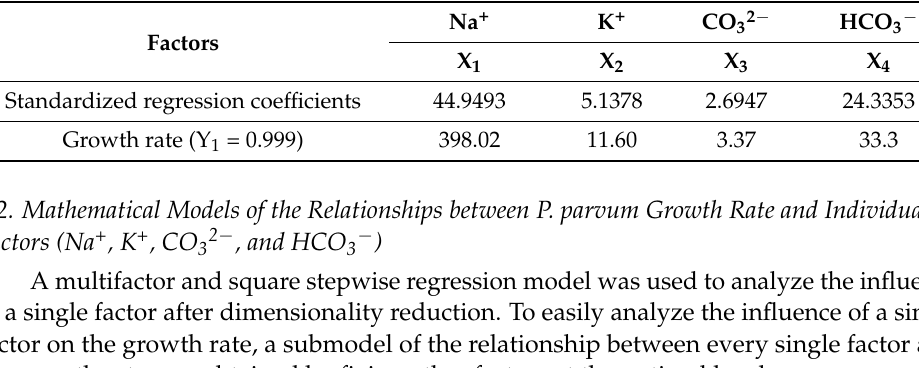
Table 5. The standardized regression coefficients of the model and optimal combination.